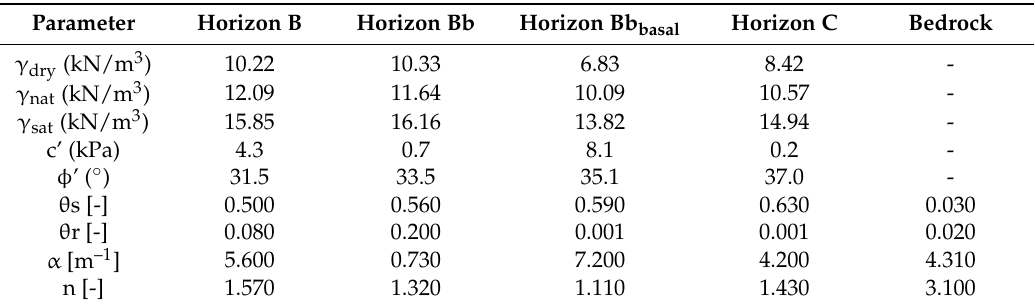
Table 2. Unsaturated hydraulic and mechanical parameters considered for the VS2DTI hydrological modeling [39].